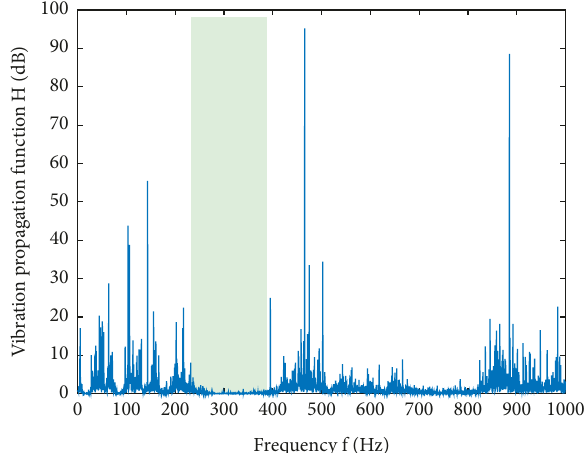
Figure 20: Vibration propagation function of response